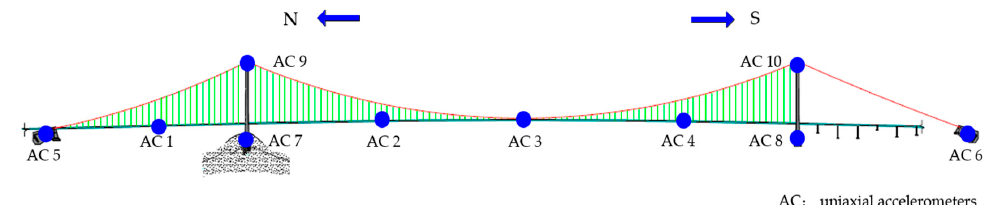
Figure 14. Location of accelerometers in bridge girder and pylon.